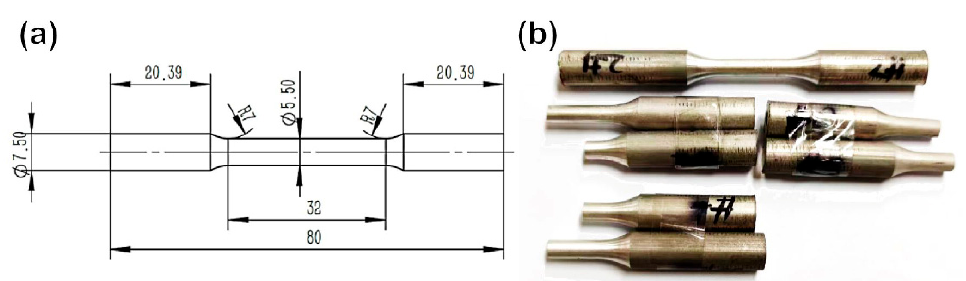
Figure 1. Dimensions of samples used in room temperature tensile test ( a ) and the specimen af- ter/before fracture ( b ).